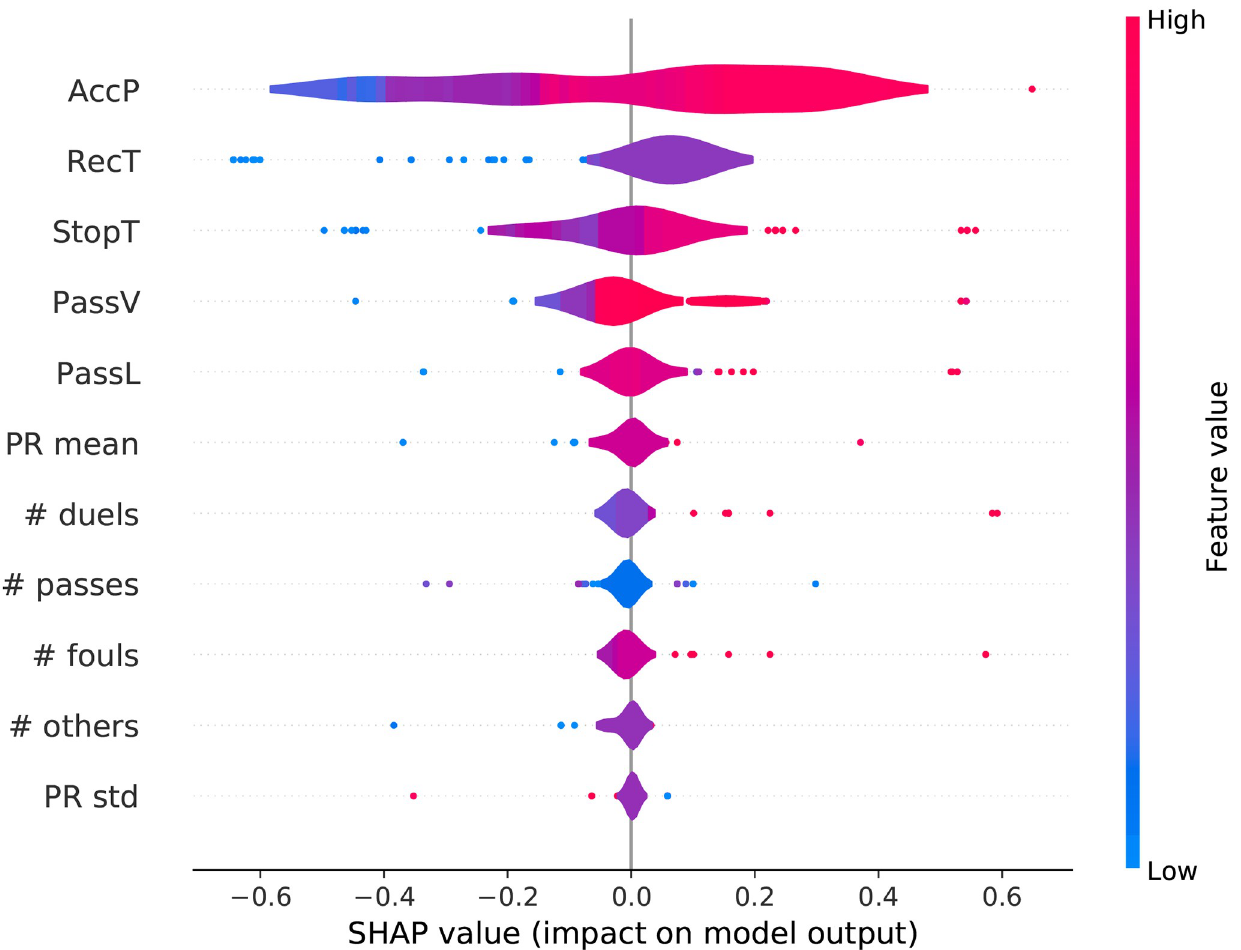
Fig 7. Distribution of the impact of each feature on the team gender classifier. The color represents the feature value (red high, blue low); and position of the point indicates the Shap value.